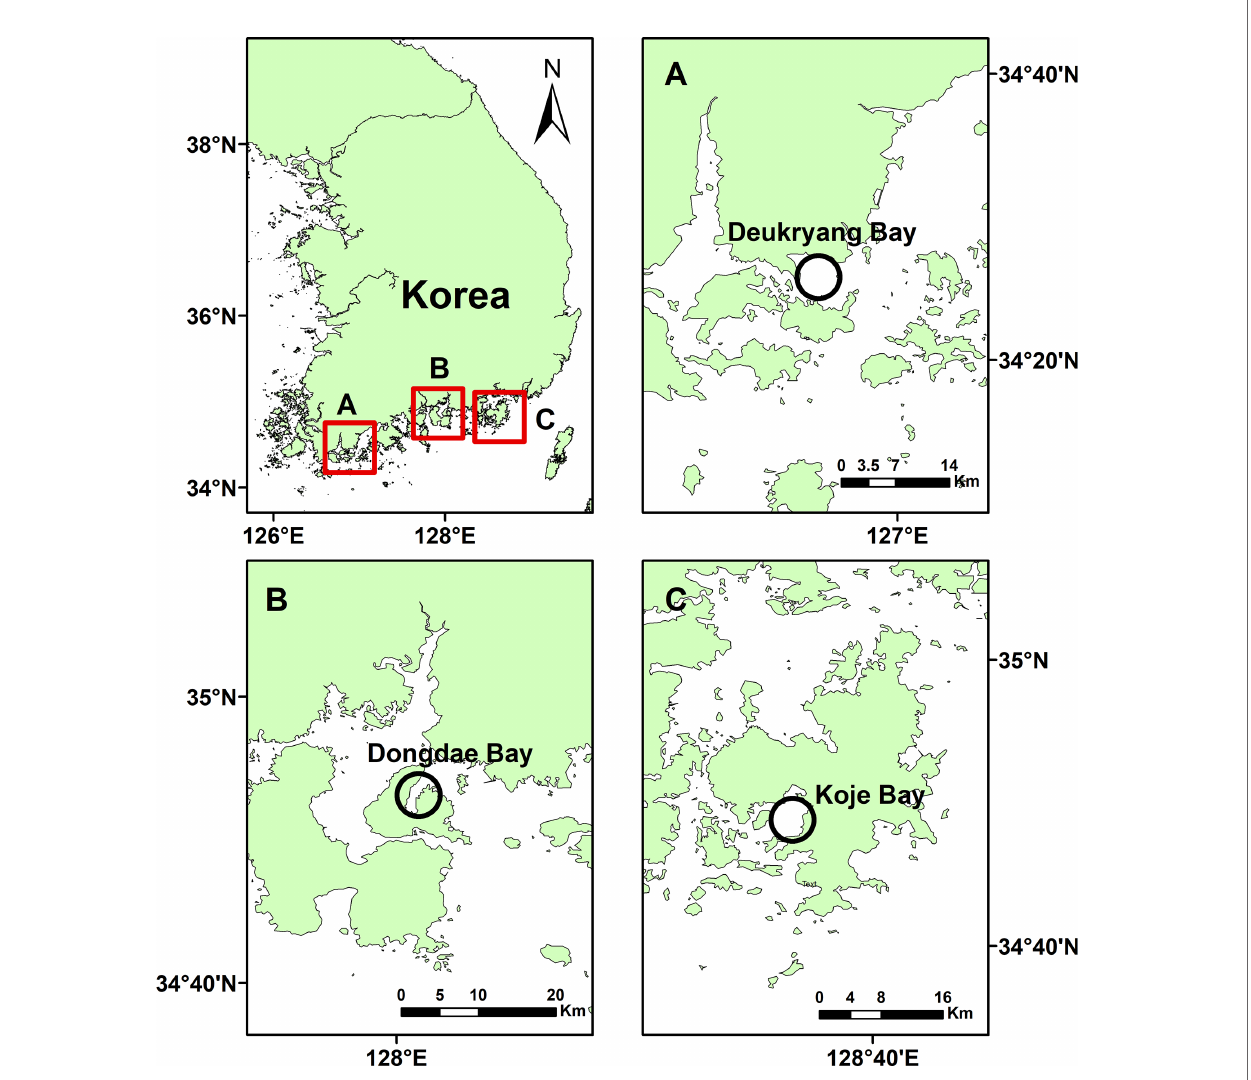
FIGURE 1 | Map showing the three study sites in Deukryang Bay (A) , Dongdae Bay (B) , and Koje Bay (C) on the southern coast of